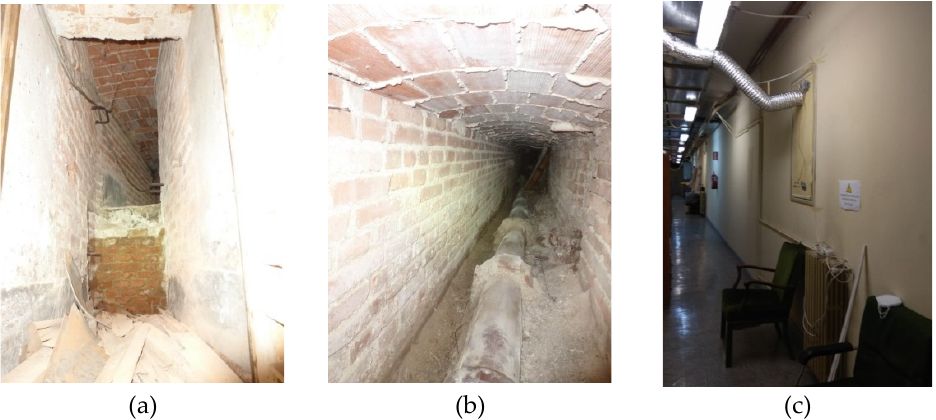
Figure 4. ( a ) Gallery A, inner space observed from the entry door. ( b ) Gallery A, back. Inner space observed from Hole 1. ( c ) Gallery A, corridor, and door with the extraction system.